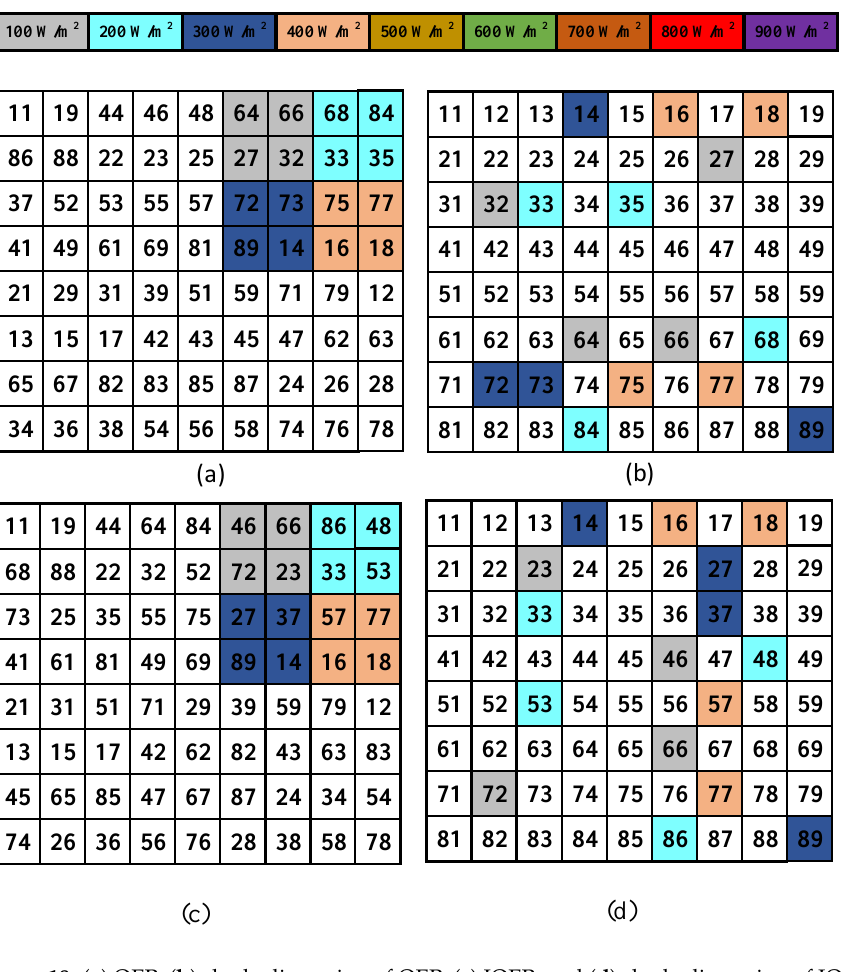
In Case-3, in the Bottom-Left corner, 16 PV modules are partially shaded, as seen in the Figure